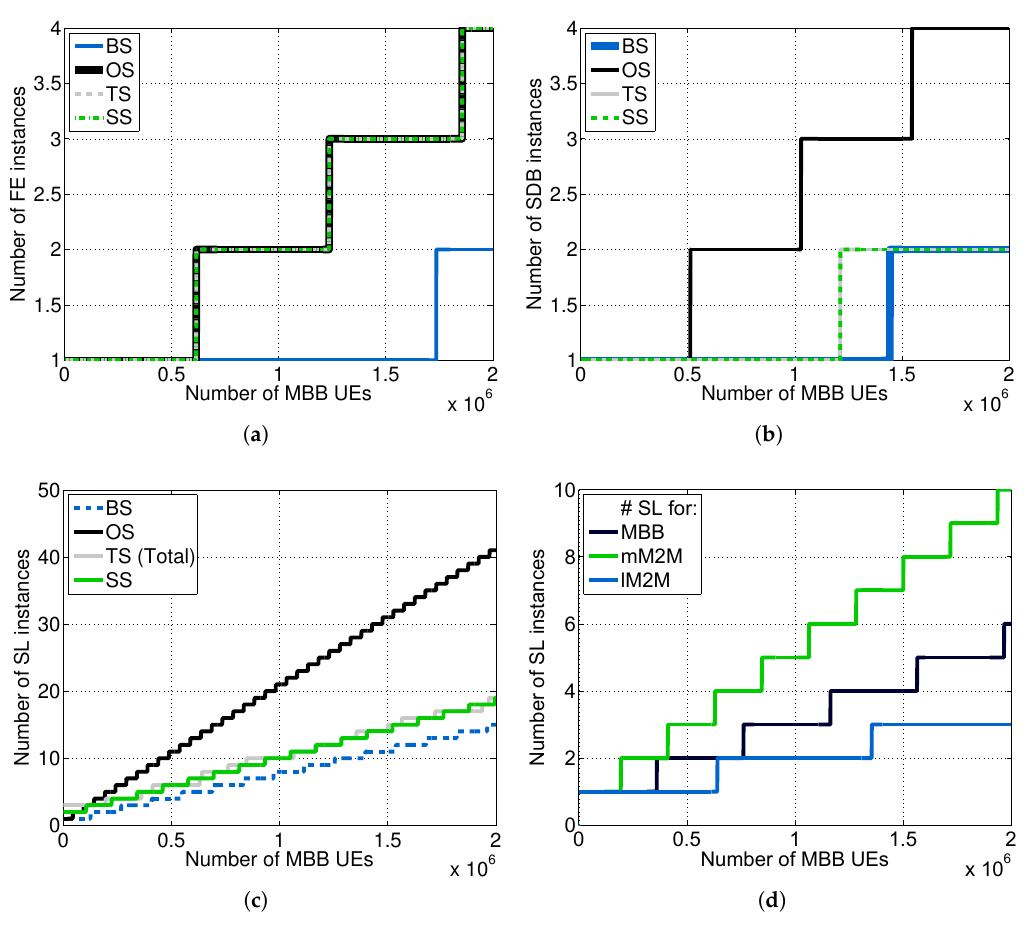
Figure 10. Dimensioning at each tier of the vMME model (ten M2M devices per MBB UE). ( a ) FE dimensioning; ( b ) SDB dimensioning; ( c ) SL dimensioning; ( d ) Detailed SL TS dimensioning.